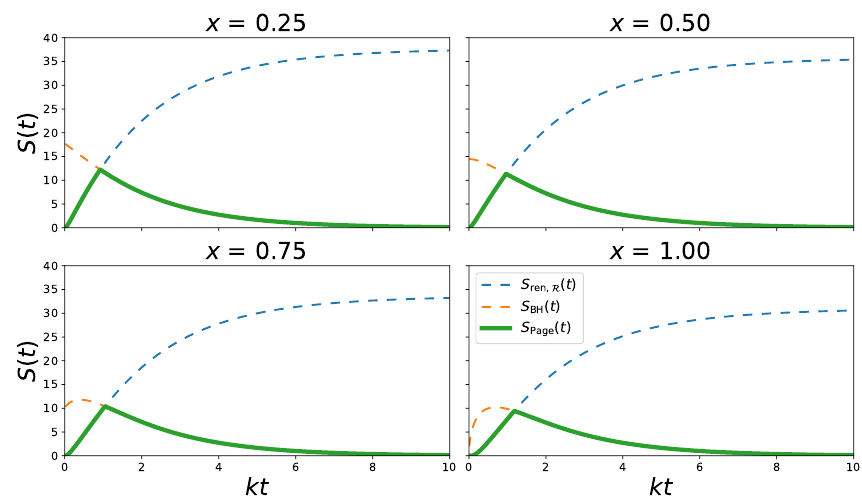
Figure 11 . The Bekenstein-Hawking (6.31) and matter radiation entropy S ren , R ( t ) (3.24) plotted for different values of x = Q 2 0 with fixed E = 20 , k = 0 . 1 and K = 4 C . For x = 0 . 75 , 1 . 00 we see 0 2 E 0 K the appearance of a maximum at t as was elaborated upon in the main M